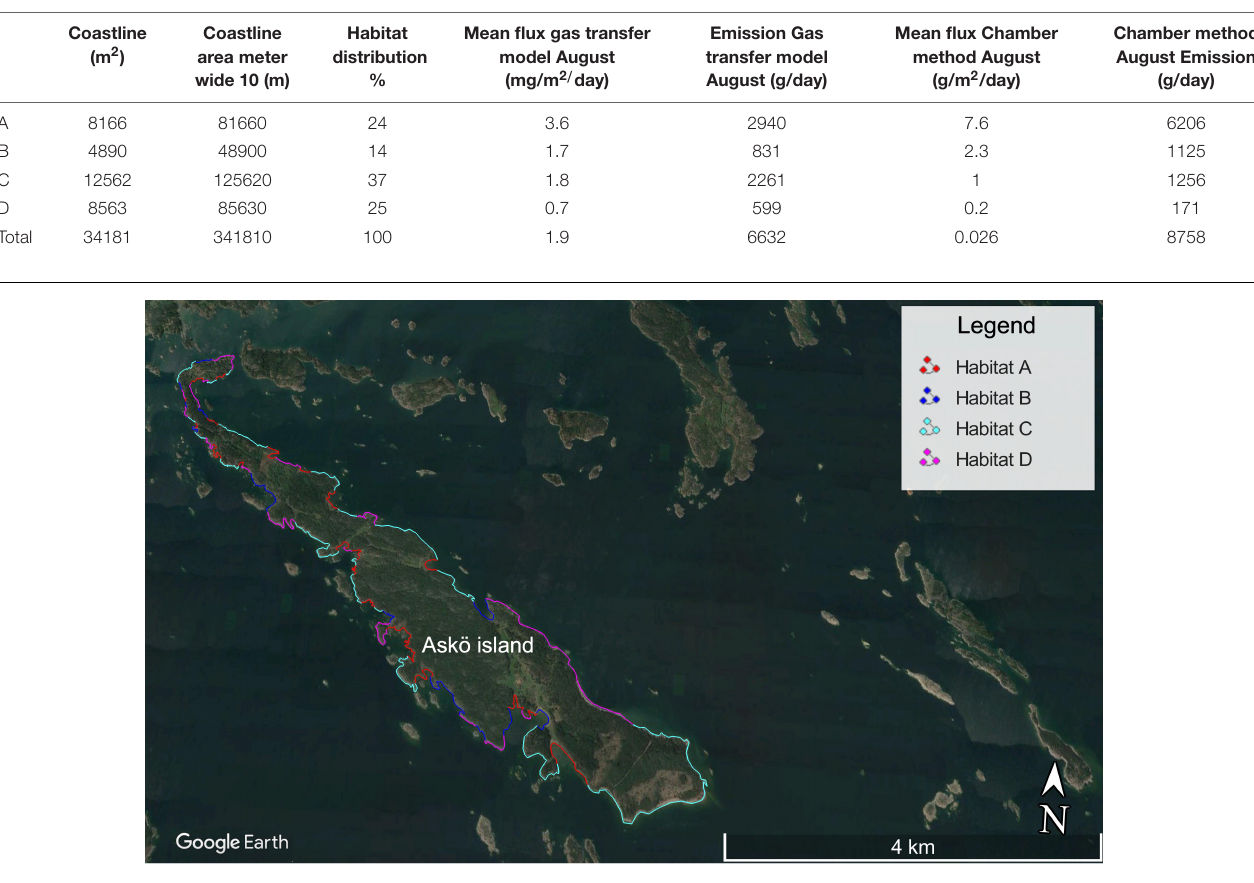
TABLE 3 | Scaled methane emissions for August 2019 for the total coastline of the island of Askö.